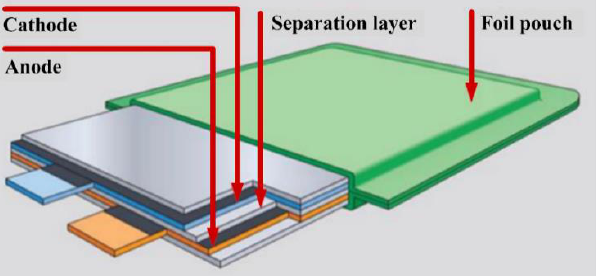
Figure 27. Basic construction of sandwich like Li-polymer cells. A typical Li-Po battery consists of a positive electrode, negative electrode, electrolyte, and a separator [102].